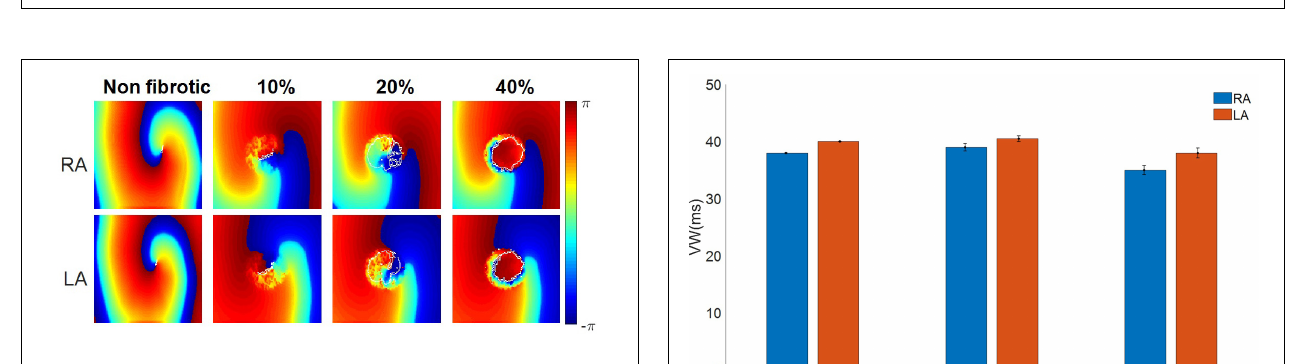
FIGURE 7 | Instantaneous phase maps and phase singularities (in white) for different densities of myofibroblasts (non-fibrotic, 10, 20, and 40%) in the right atria (RA) and left atria (LA) under conditions of persistent AF remodeling.